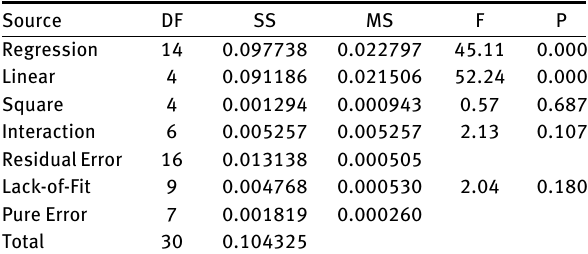
Figure 2: Normal Percent plot of residuals for tool wear.